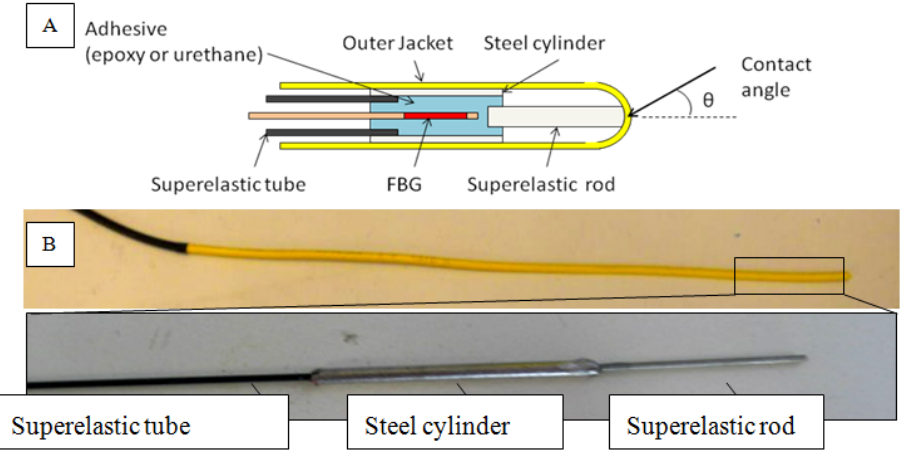
Figure 1. ( A ) Schematic of the sensor head; ( B ) Photos of the sensor exterior and